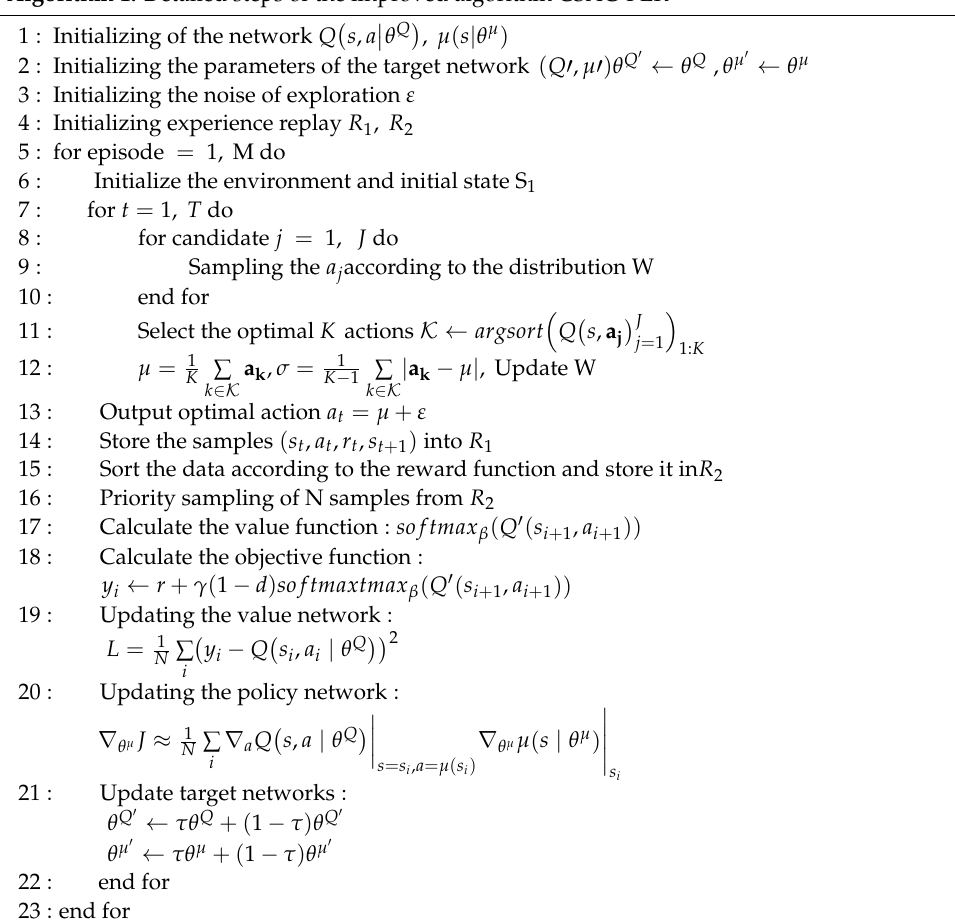
Algorithm 1. Detailed steps of the improved algorithm